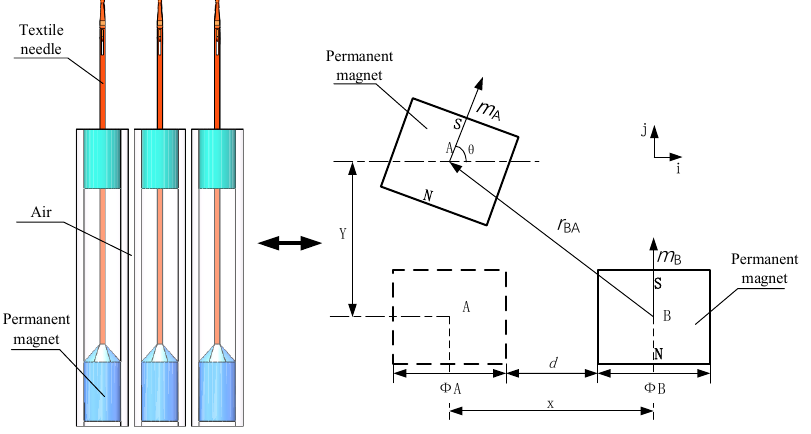
Figure 2. Simplified model of interaction between two permanent magnet needles.